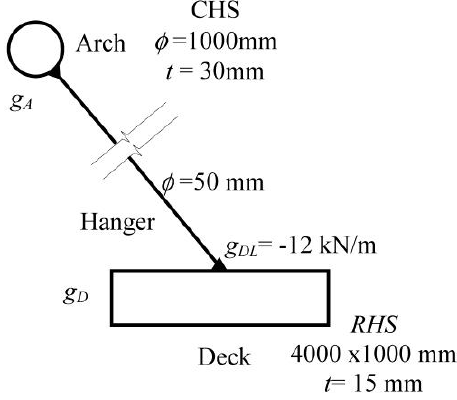
Figure 11. Reference bridge: cross-section and loads considered.